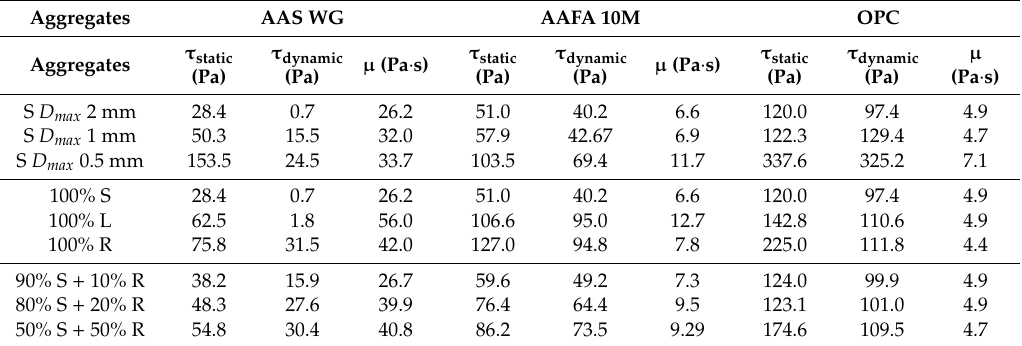
Figure 3. Flow curves for: ( a ) AAS-WG, ( b ) AAFA-10M, and ( c ) OPC with siliceous (2S), limestone (2L) or recycled (2R) aggregate and identical particle size distributions with D max = 2 mm. Table 8. Static ( τ static ) and dynamic ( τ dynamic ) yield stress and µ in fundamental units for the mortars studied, bearing siliceous, limestone, or recycled